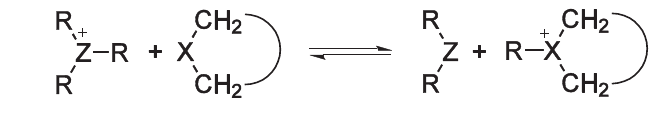
Figure 19. Initiation by onium-ions (Z and X may be identical, e.g., oxygen).